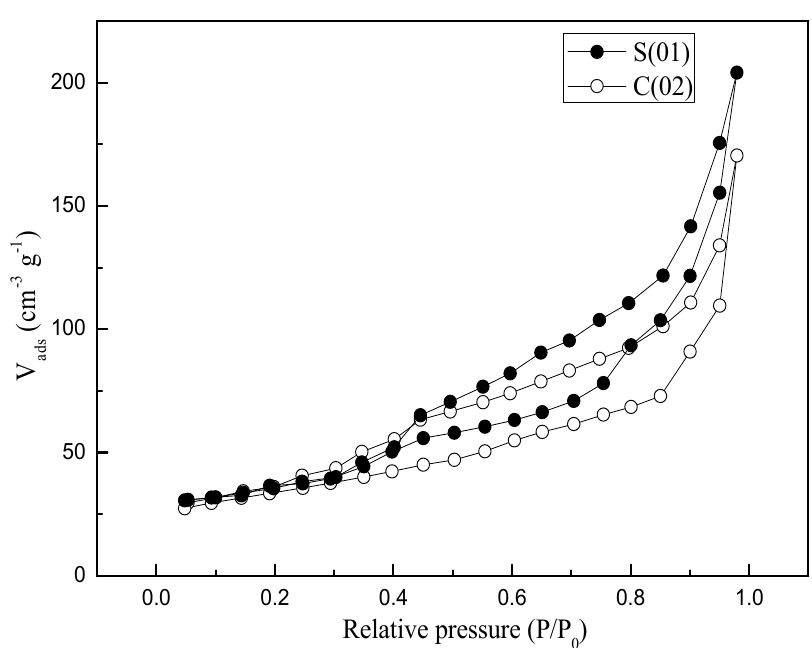
Figure 7. N 2 adsorption/desorption isotherms of MnO 2 obtained in S-CFMCR and C-CFMCR, respectively.